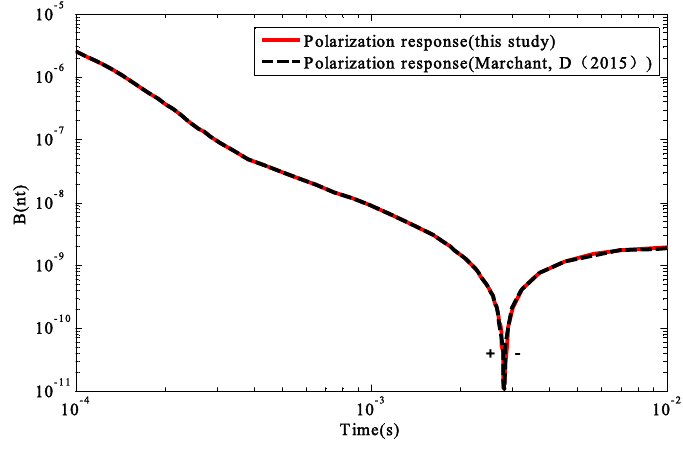
Figure 7. Comparison of this study with that of Reference [29].